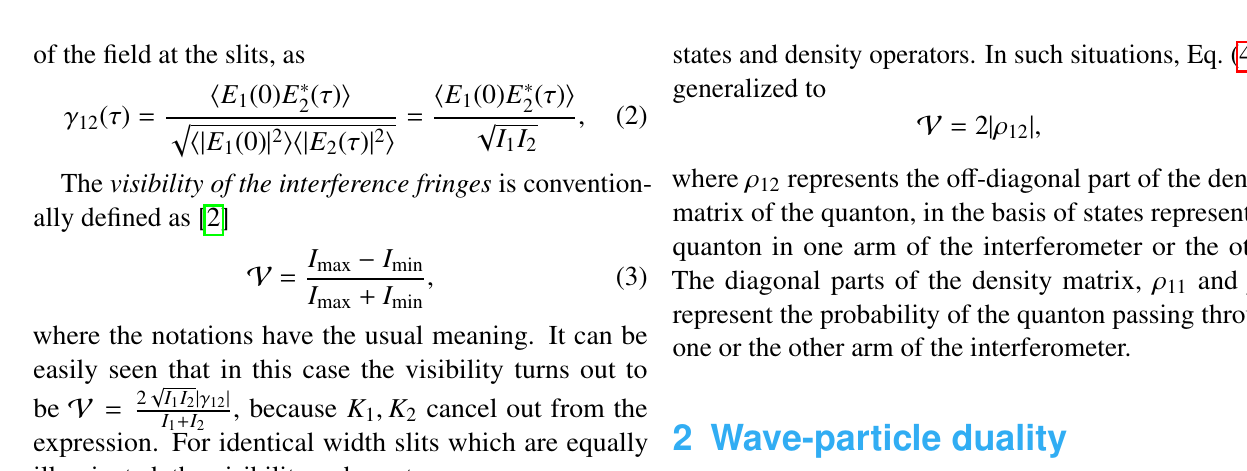
Figure 1: Schematic diagram of a two-slit interference experiment. There are two possible paths a quanton can take, in arriving at the